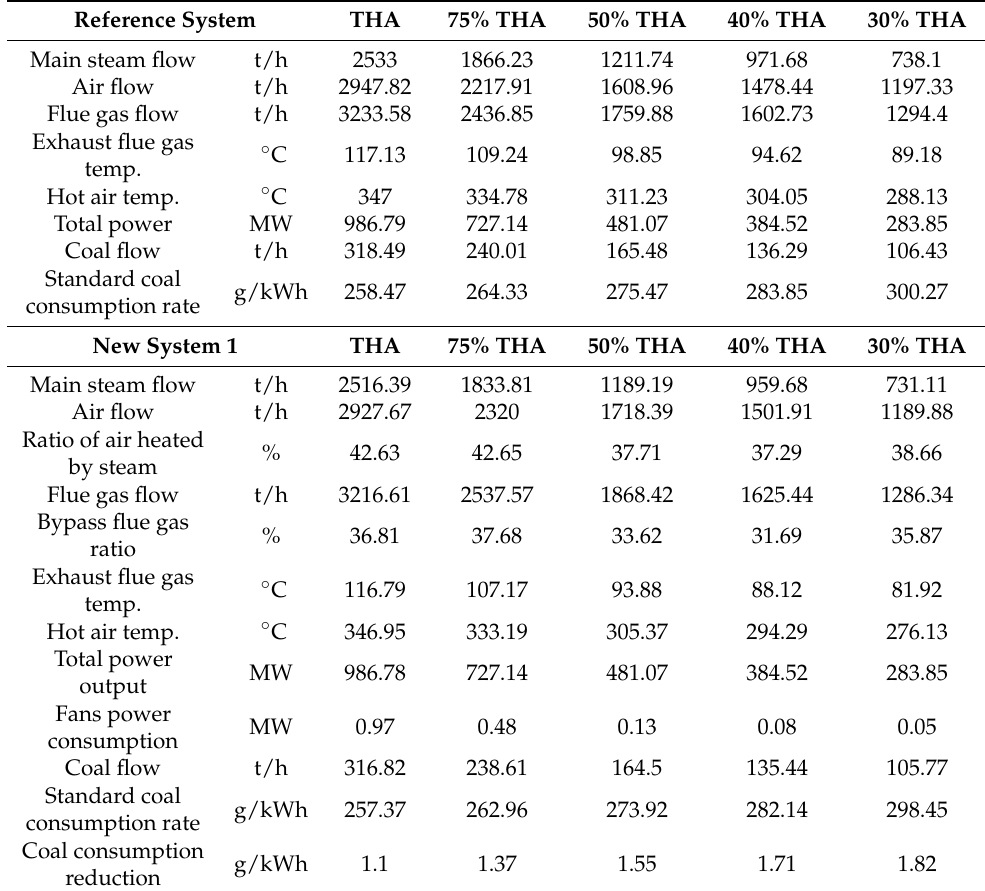
Table 3. Data of three systems under off-design